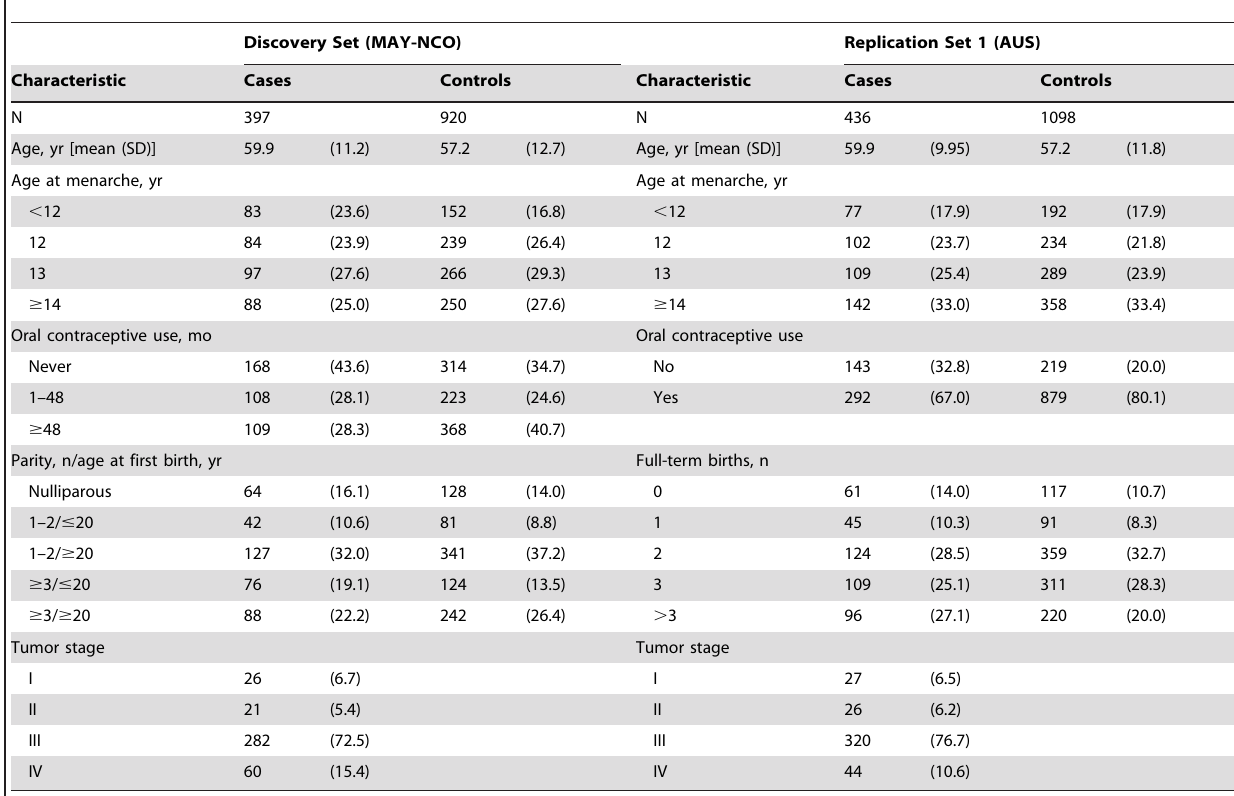
Table 1. Distribution A of selected characteristics between cases and